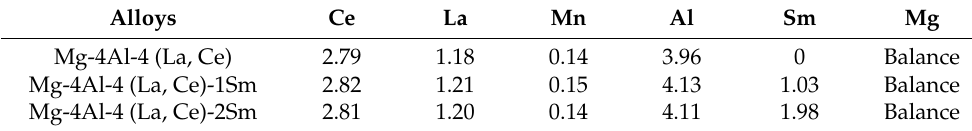
Table 1. The actual chemical composition of the alloy was studied experimentally (wt.%). Alloys Ce La Mn Al Sm Mg Mg-4Al-4 (La, Ce) 2.79 1.18 0.14 3.96 0 Balance Mg-4Al-4 (La, Ce)-1Sm 2.82 1.21 0.15 4.13 1.03 Balance Mg-4Al-4 (La, Ce)-2Sm 2.81 1.98